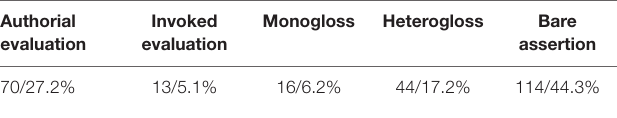
TABLE 5 | Evaluative meaning of pseudo-clefts (raw